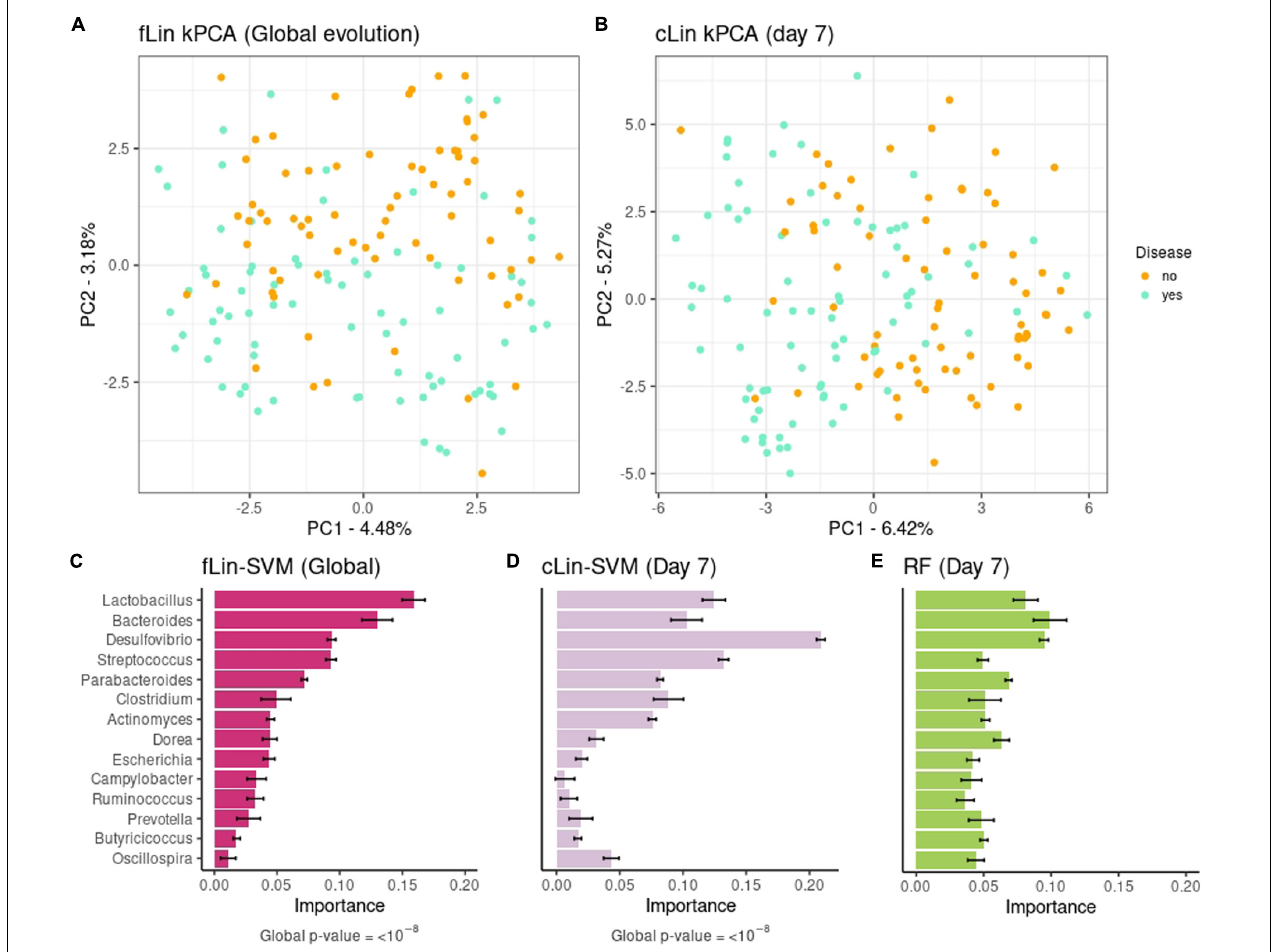
FIGURE 5 | Above: kPCA of fLin in panel (A) and of cLin (day 7) in panel (B) . Below: Microbial signatures at the Genera level. Global importance for the first week is in panel (C) . Importances for the day 7 according to the cLin kernel and RF are in panels (D,E) . Standard error across the 40 replicates is marked with error bars.